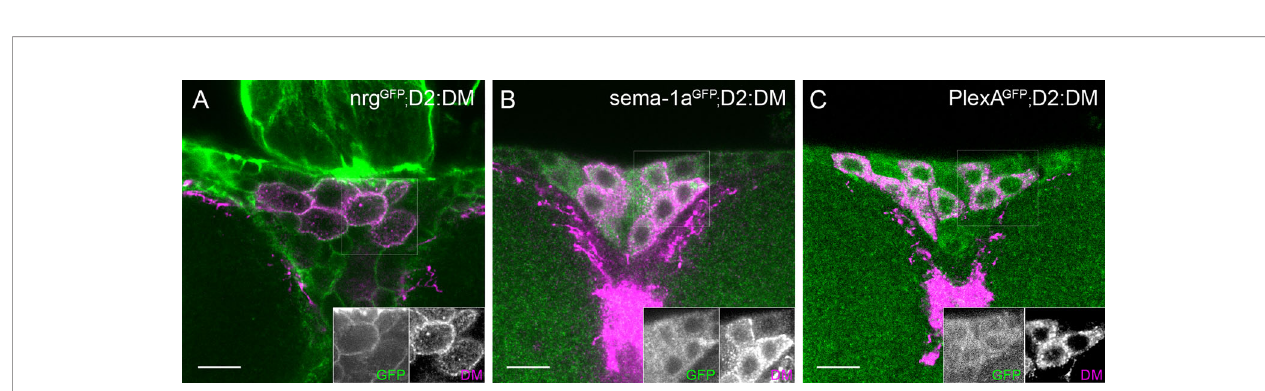
FIGURE 7 | Expression of the signaling molecules Sema-1a and PlexA in the IPCs. Similar to Nrg (A) , both Sema-1a (B) and PlexA (C) are expressed in the IPCs as well as in neighboring